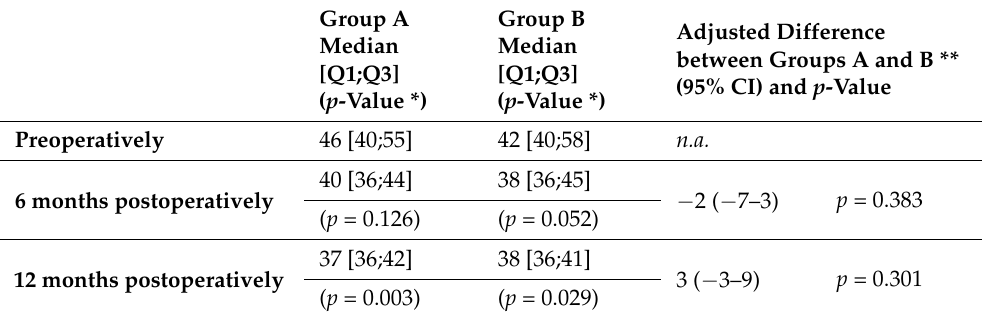
Table 2. Median HIT-6 scores [Q1;Q3] and differences between groups.